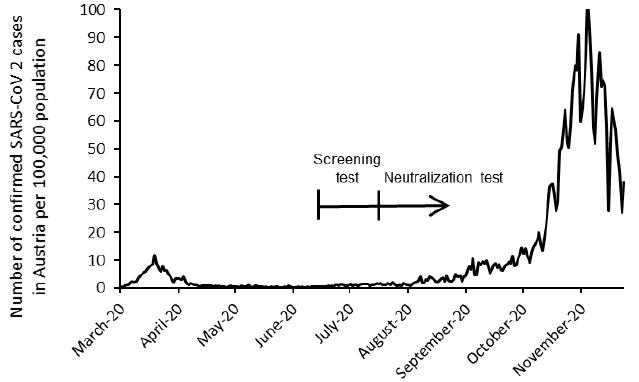
Figure 1. Timeline of the study in context of the epidemiologic situation in Austria.